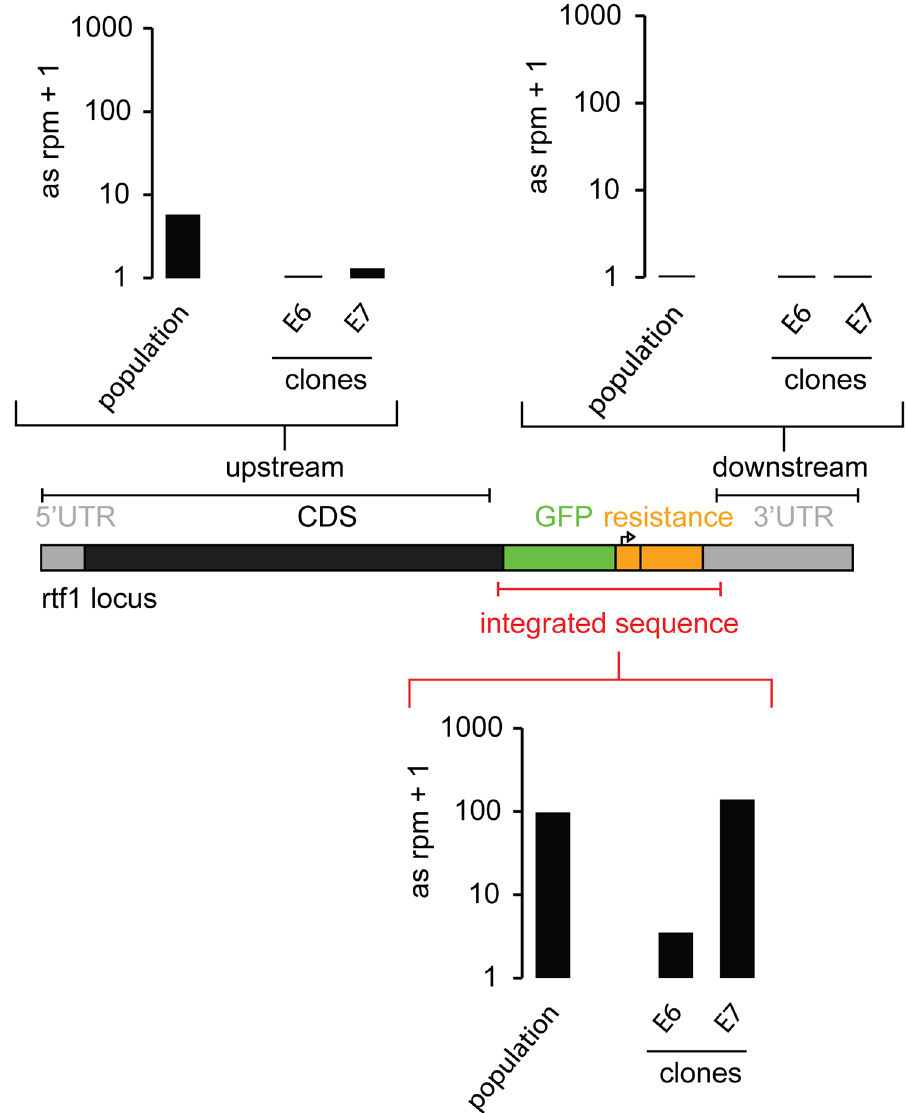
Fig 5. Quantification of the siRNA strength at the rtf1 locus for different cell lines. SequencedsiRNAs were mapped to the modified loci and antisensereads mappingeither to the upstream or downstrem regionof the integrated sequenceor the HR donor were summed up and normalized to genome matchingreads and length of the sequenceregion.